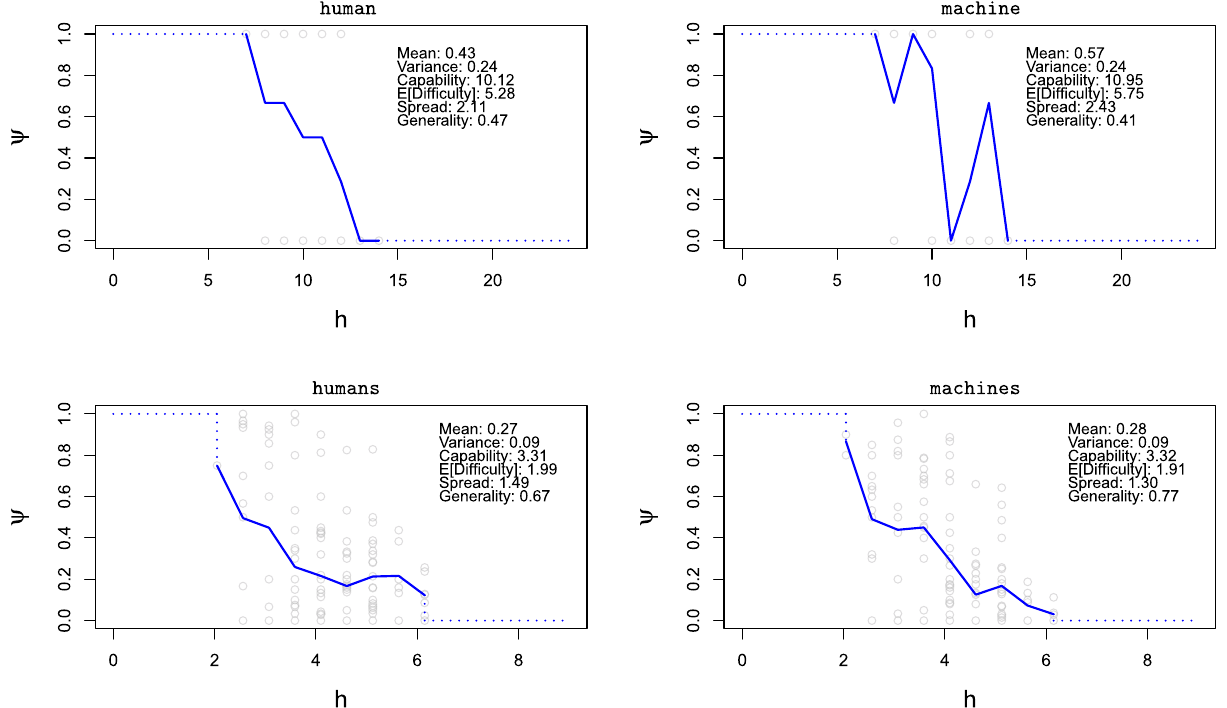
Figure 2. Agent characteristic curves (ACC), showing agent responses in terms of difficulty ( h ). The responses are shown as grey circles. The means of these responses for each difficulty are shown in blue, and connected to form an ACC. The plot shows the values for mean performance and its variance (Bernoulli: p ( 1 when responses are binary), capability ( (cid:31) j ), expected difficulty ( H j ), spread ( S j ) and its reciprocal, generality ( Ŵ j ). The more compact the curve is, like a single steep fall, the higher the generality. Note that generality cannot be calculated from curve slopes. Top: a human (left, subject #22) and a machine (right, ‘repdiff’), both on 25 instances of the letter series problems as described in the text. The human has higher generality and lower capability than the machine. Bottom: an aggregation of human population (left) and an aggregation of Q-learning agents (right), both for 140 experiments from a benchmark comparing humans and simple reinforcement learning algorithms 29 . With similar capability, machines are more